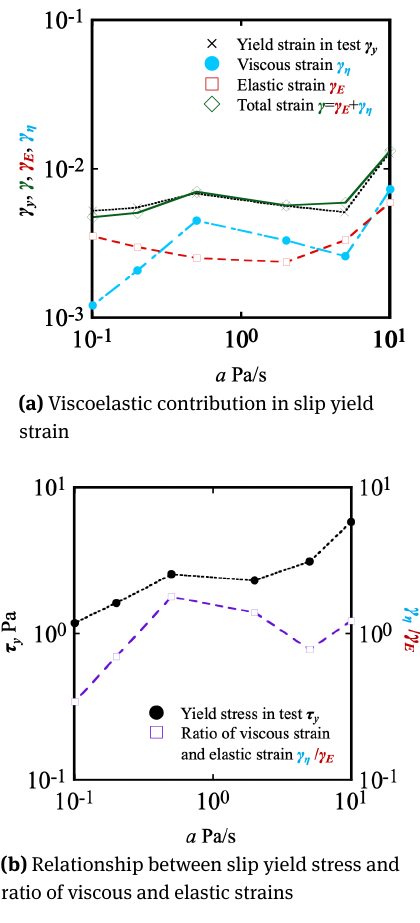
Figure 13: Applicable range of the single relaxation Maxwell model. The correlation coeflcient R 2 decreases just before the yield point.